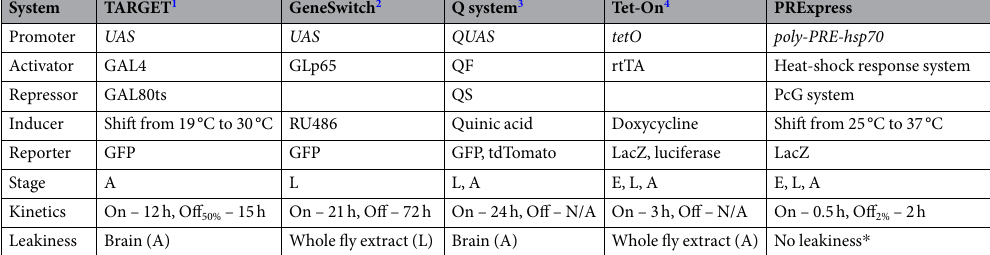
Table 1. Systems for temporal gene expression control in Drosophila . A – adult, L – larva, E – embryo. * – see results and